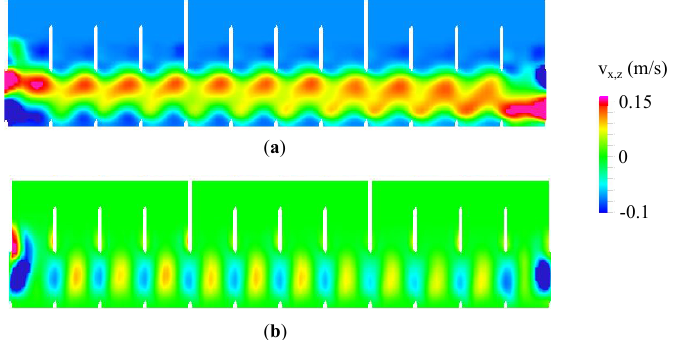
Figure 16. Particle velocities averaged over approximately 150 s in ( a ) horizontal ( v x ) and ( b ) vertical ( v z )